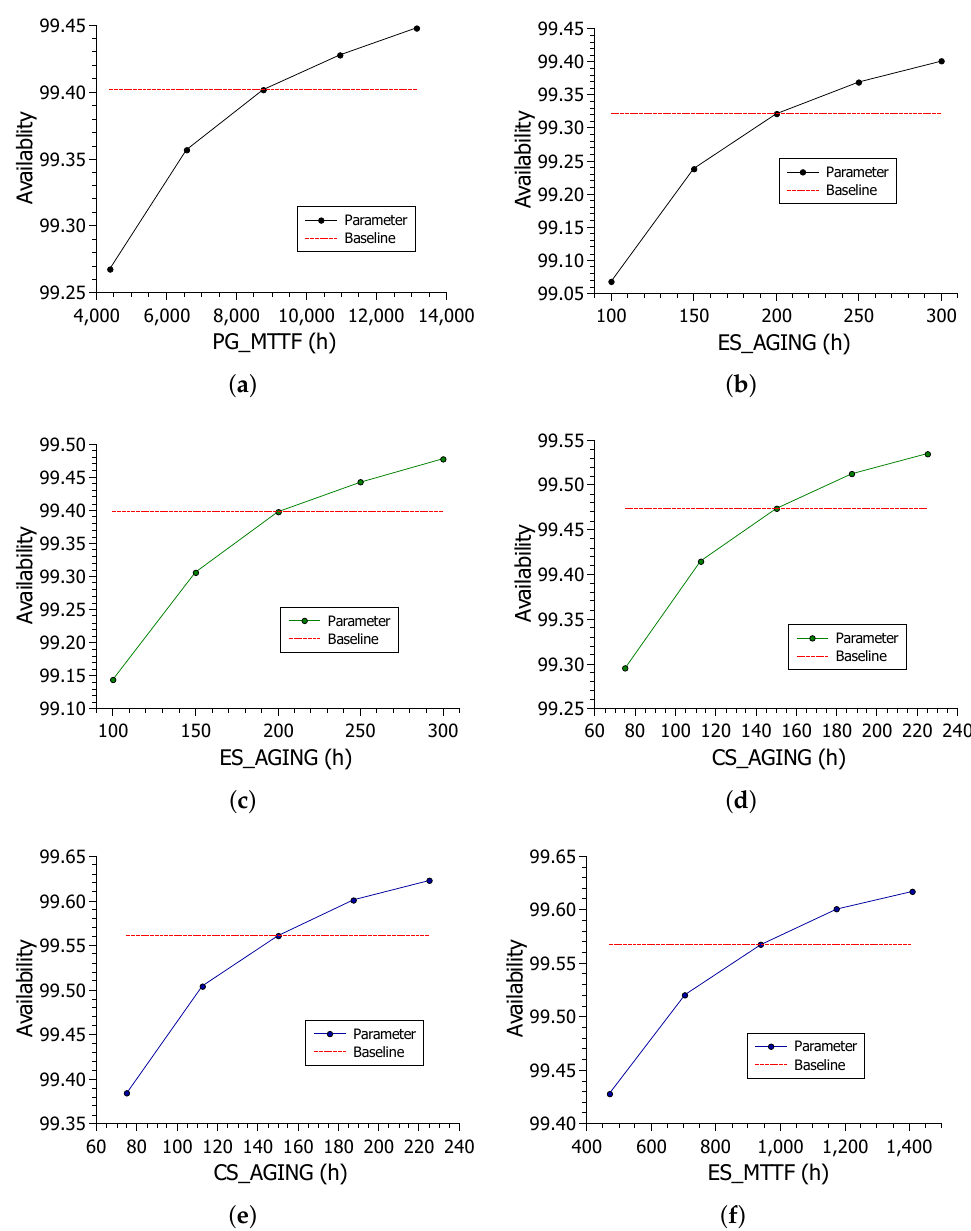
Figure 9. Results for the sensitivity of availability models: ( a ) PG_MTTF × model A; ( b ) ES_AGING × model A; ( c ) ES_AGING × model B; ( d ) CS_AGING × model B; ( e ) CS_AGING × model C; ( f ) ES_MTTF × model